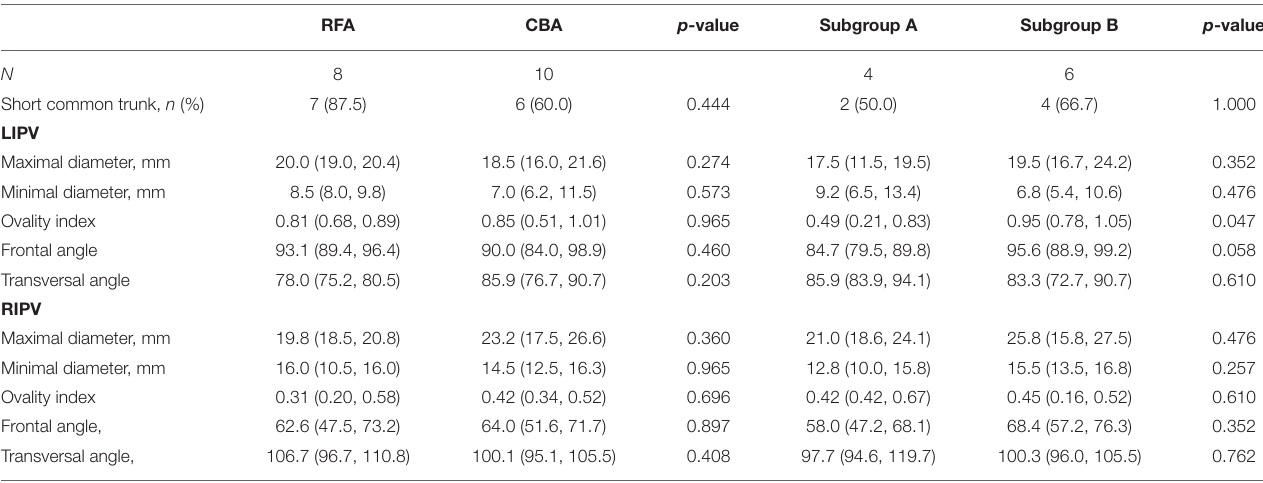
TABLE 5 | Anatomical parameters of